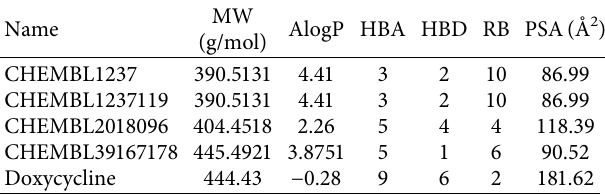
Table 1: Drug-like properties of the top lead compounds and doxycycline from QikProp module of Schr¨odinger